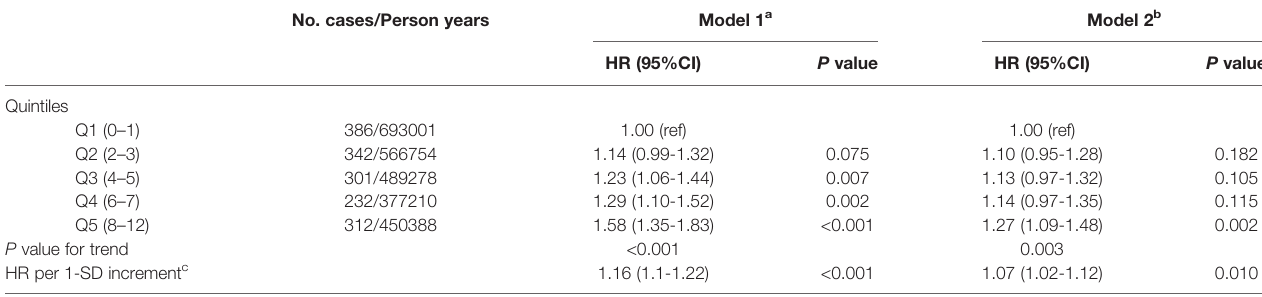
TABLE 2 | Association between neuroticism and risk of incident lung